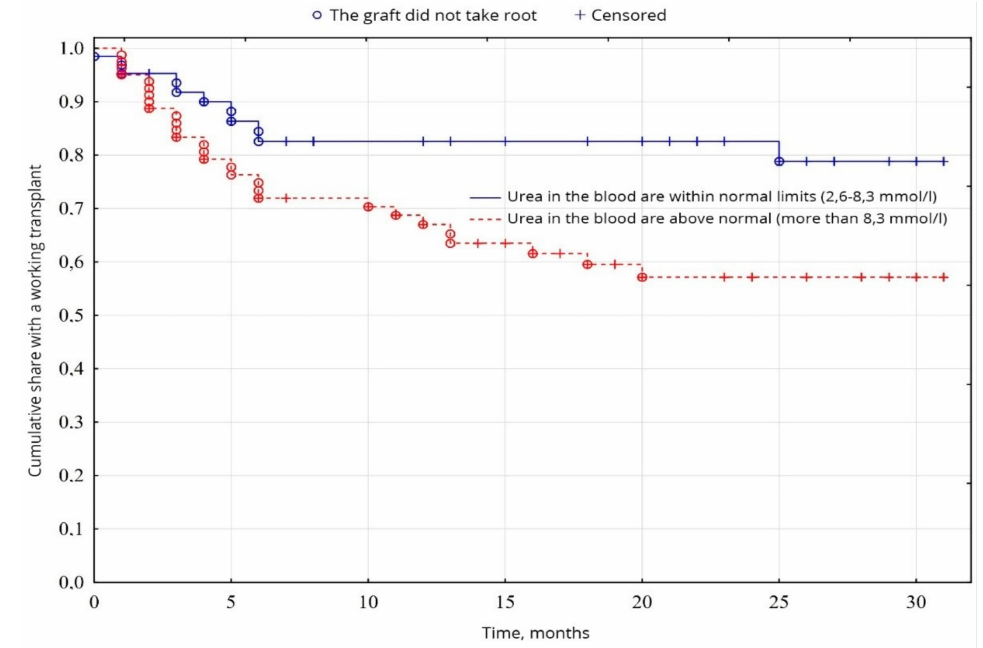
Figure 6. Evaluation of graft function depending on urea in the blood.